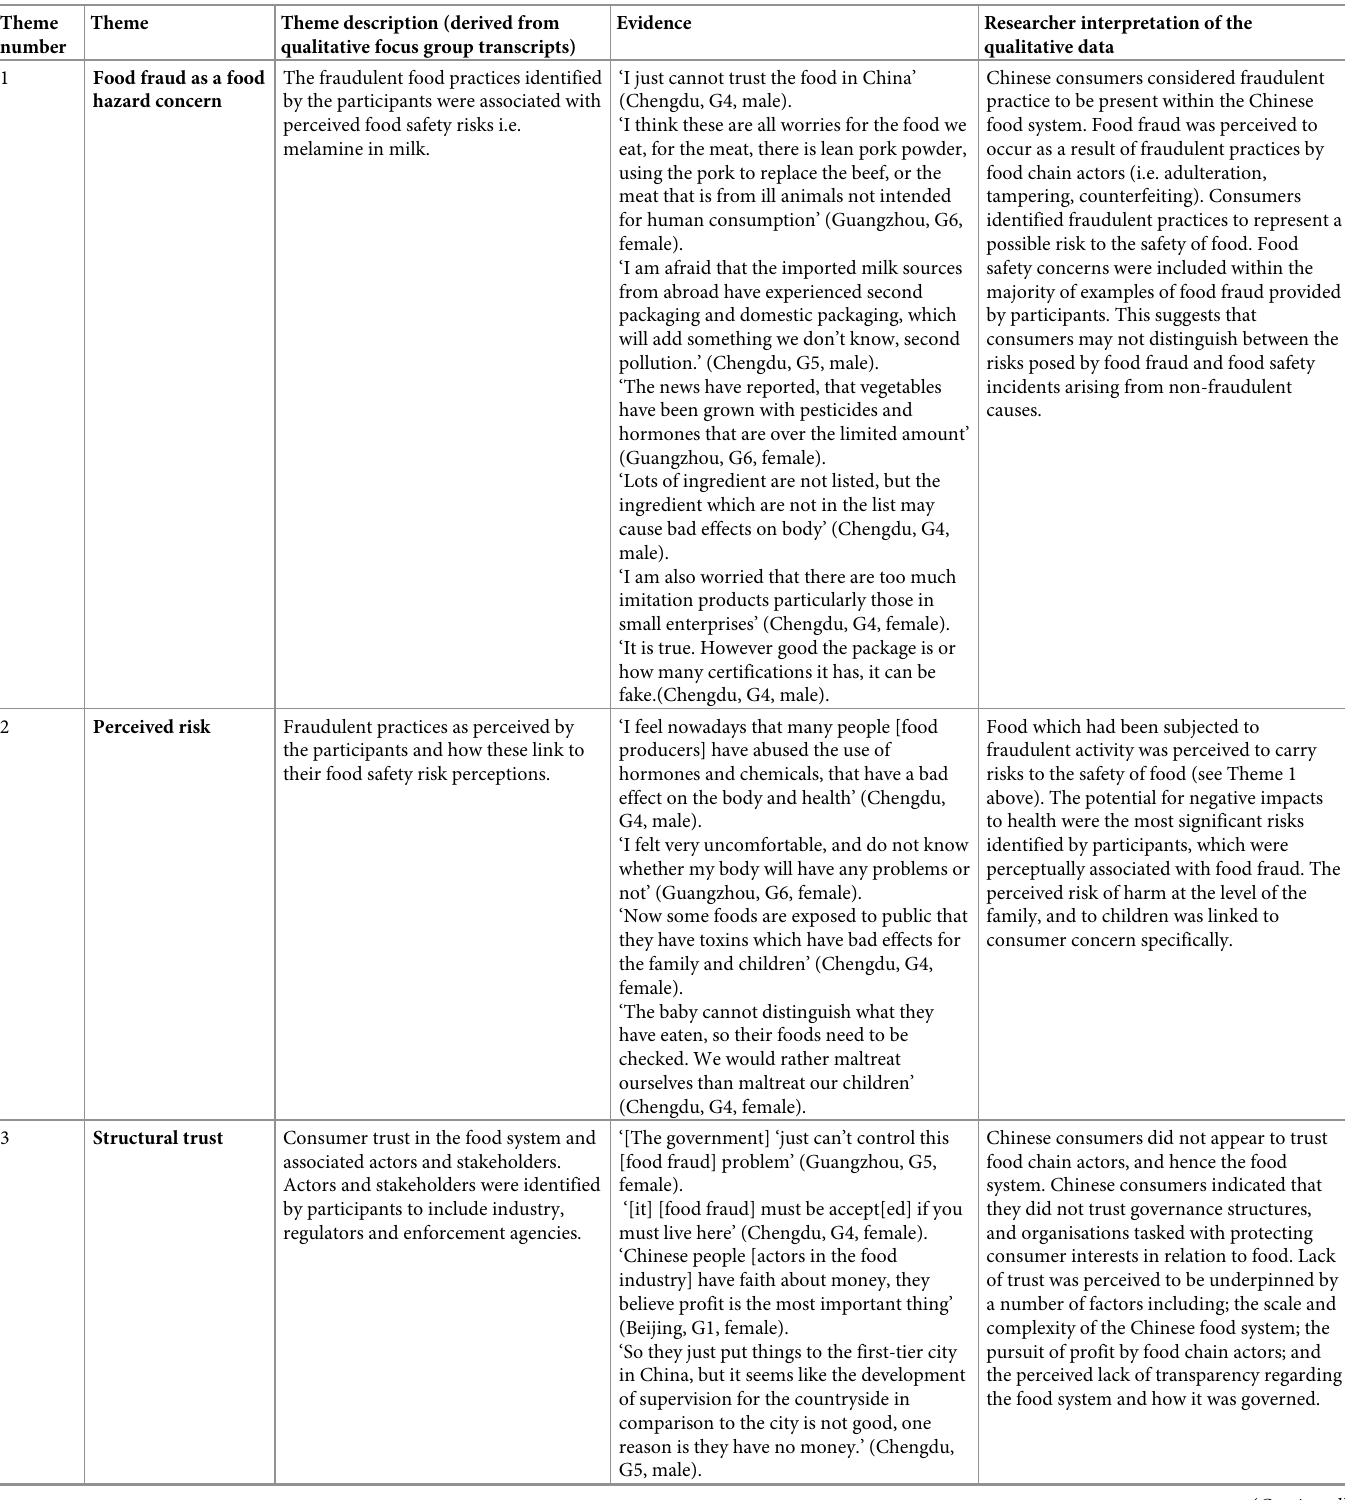
Table 4. Focus group discussions: Emergent themes supporting evidence and researcher interpretations of the data. Theme number